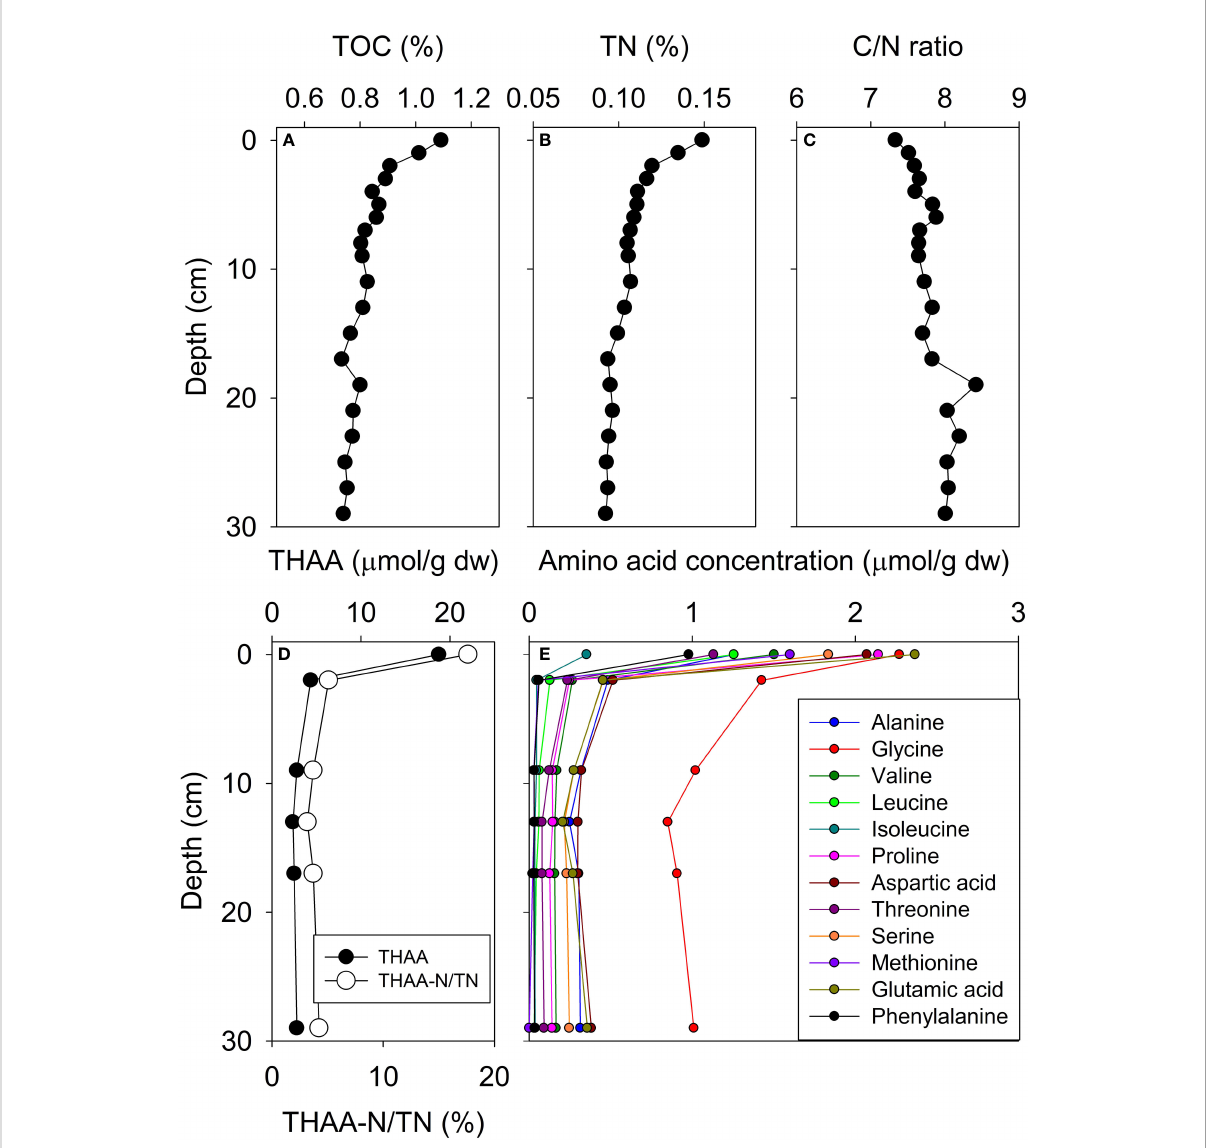
FIGURE 2 Vertical pro fi le of core D10. TOC (A) , TN contents (B) , C/N ratio (C) , THAA concentration and THAA-N/TN percent (D) , and individual AA concentrations (E)